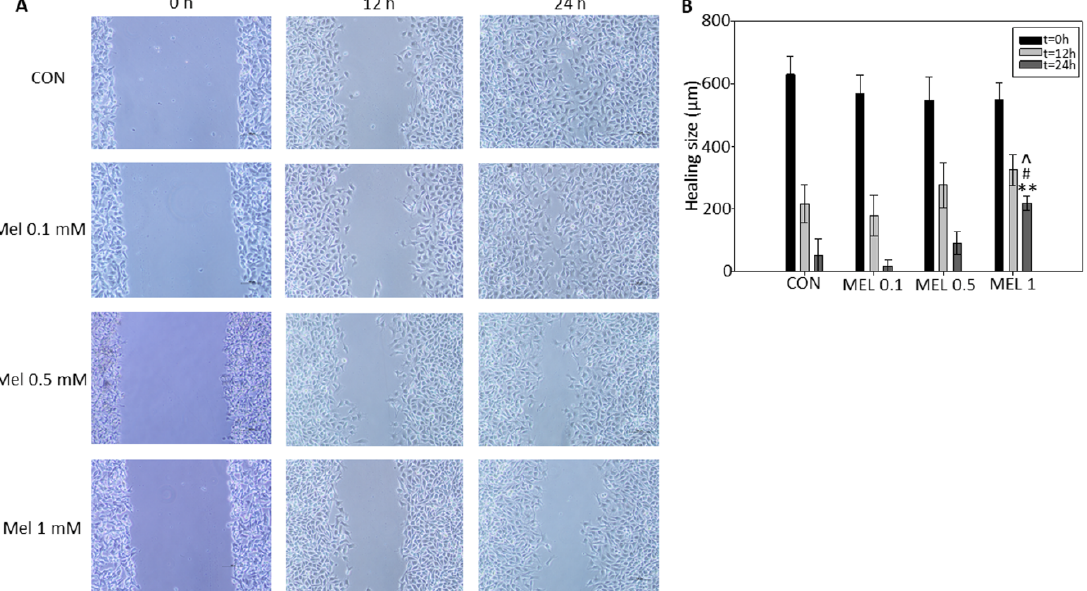
Figure 5. B16-F10 cell migration after incubation with di ff erent concentrations of melatonin. ( A ) Wound healing assay of each experimental group, images were taken at a magnification of 40. ( B ) Wound healing average size of each experimental group. Data were shown as average +/ − SEM. Significance vs. CON 24h. ˆ p < 0.05, significance vs. Mel 0.5 24h. # p < 0.05, significance vs. Mel 0.1 24 h. ** p <